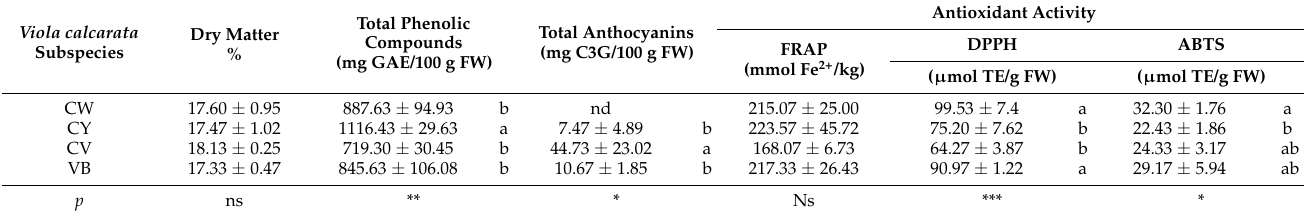
Table 2. Dry matter, total phenolic compounds, total anthocyanins, and antioxidant activity in V. calcarata subsp. calcarata white (CW), V. calcarata subsp. calcarata yellow (CY), V. calcarata subsp. calcarata violet (CV), and V. calcarata subsp.